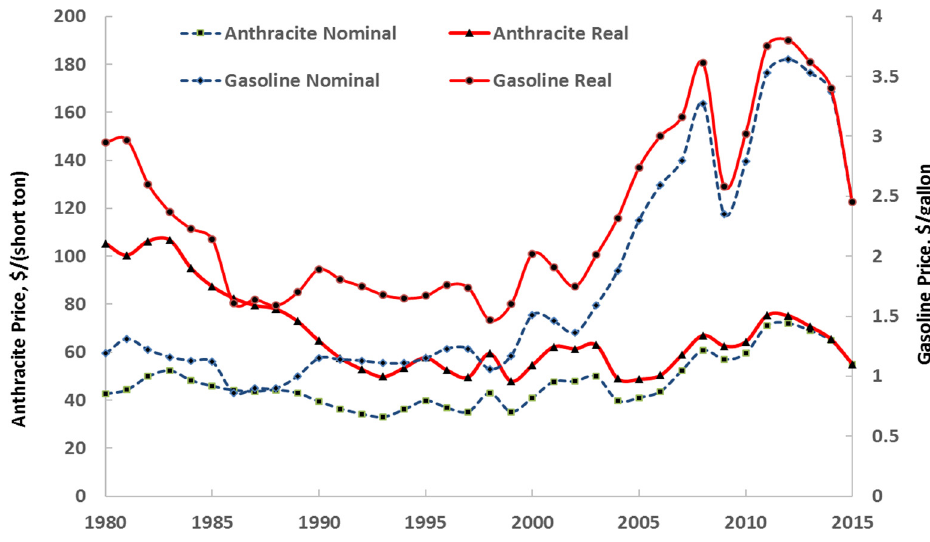
Figure 11. Nominal and real price fluctuations of anthracite and gasoline in the USA. Data from [243] and [244].